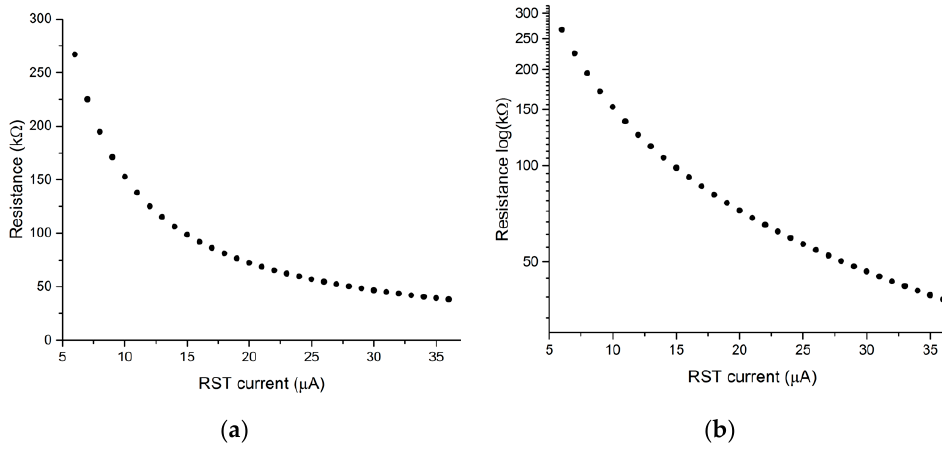
Figure 8. Evolution of the HRS resistance versus the RST compliance in ( a ) linear and ( b ) log scale for I refR ranging from 6 μ A to 36 μ A.